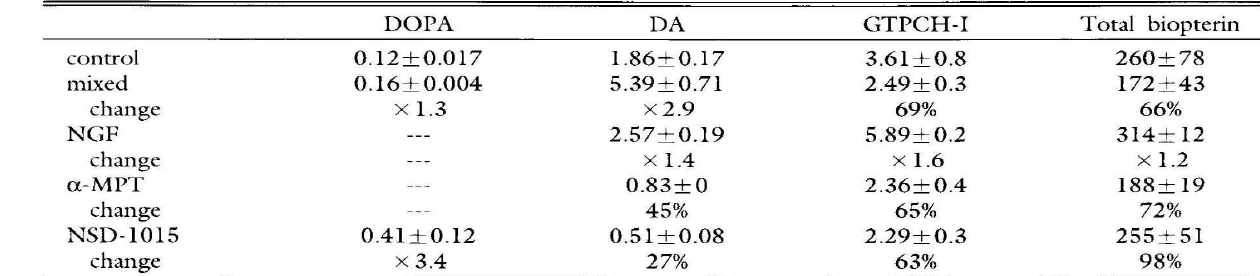
Table 1. The influences of treatment of various agents on contents of DA, total biopterin and GTPC H-I activity